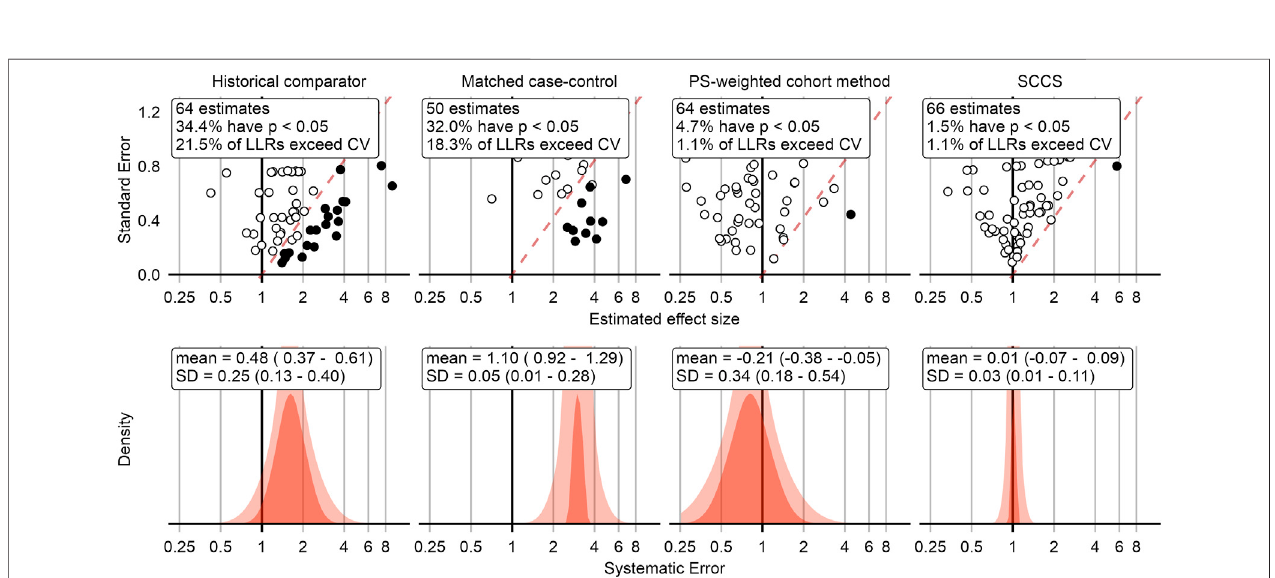
FIGURE2| Negativecontroloutcomeeffectsizeestimatesand fi ttedsystematicerrordistributionsforfourexamplemethodvariations.Inthetoprow,dotsindicate the estimated effect size ( x -axis) and corresponding standard error ( y -axis), which is linearly related to the width of the con fi dence interval. Estimates below the red dashed line have a one-sided p -value < 0.05, and fi lled dots indicate the LLR exceeds the CV. The bottom row shows the systematic error distributions fi tted using the negative control estimates above, for the maximum likelihood estimates of the parameters (red area), and the 95% credible interval (pink area). The historical comparator variant adjusts for age and sex, and usesthe TaRafter ahistoricoutpatientvisits to estimate thebackgroundrate. The case-control design matches upto4 controls per case on age and sex. The cohort method design uses PS weighting and outpatient visits as comparator index date. The SCCS design adjusts for age and season and excludes a pre-vaccination window of 30 days from analysis. CV = Critical Value, LLR = Log Likelihood Ratio, SCCS = Self-Controlled Case Series, SD = Standard Deviation, PS = Propensity Score.